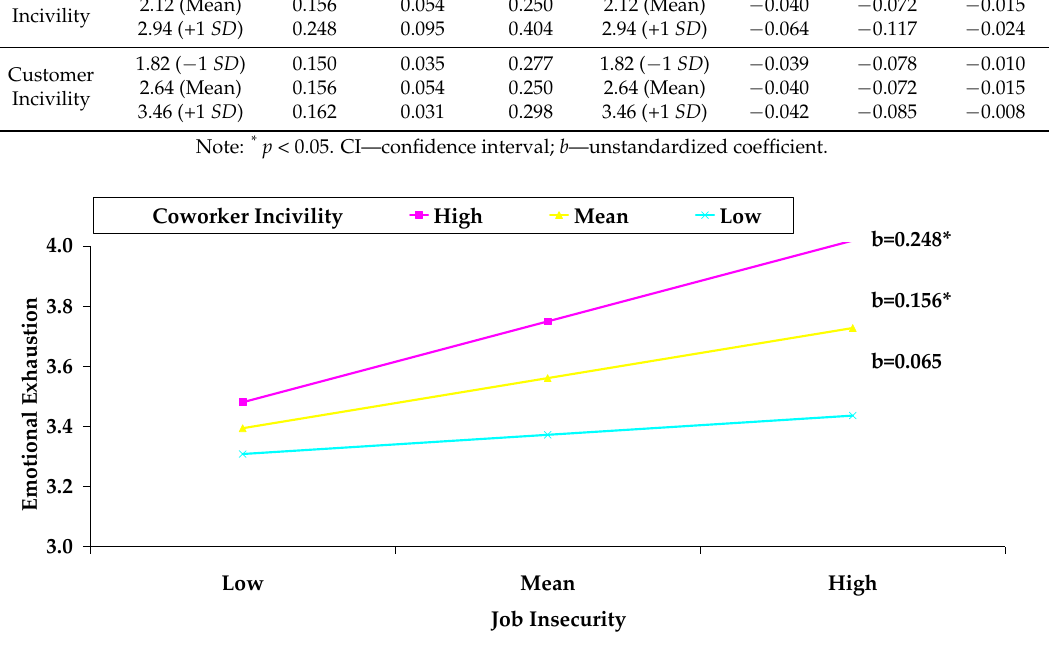
Figure 1. The moderating effect of coworker incivility on the job insecurity–emotional exhaustion relationship; Note: * p < relationship; Note: * p < 0.05.